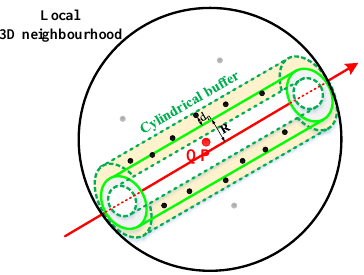
Figure 4. Cylindrical buffer established for local point density estimation along pole-like